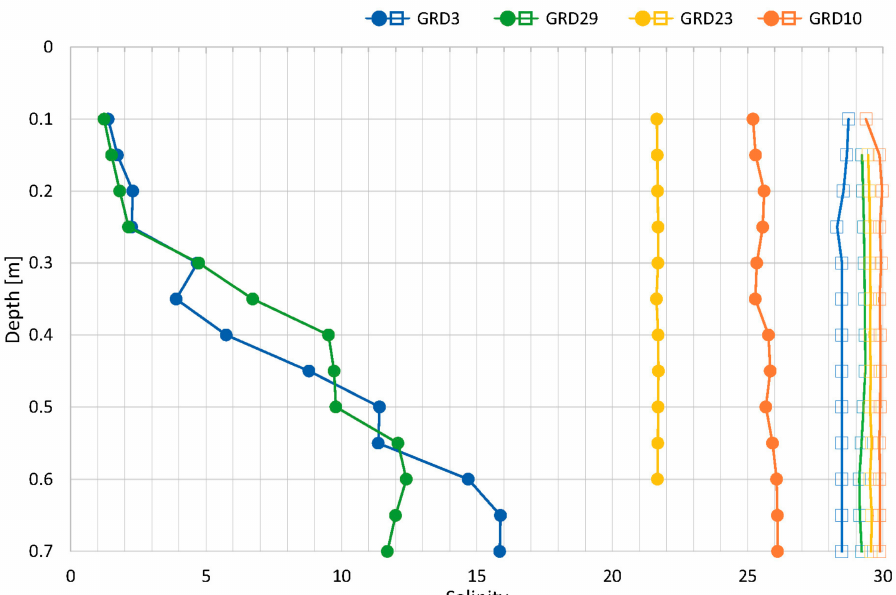
Figure 11. Vertical profiles of salinities at four different stations collected during two CTD campaigns in ante operam condition (open square symbols, 16 April 2018) and post operam condition (closed circle symbols, 10 June 2021), respectively. The color-coded stations GRD3, GRD29, GRD23 and GRD10 are located at increasing distance from the freshwater inputs, see Table 4 and Figure